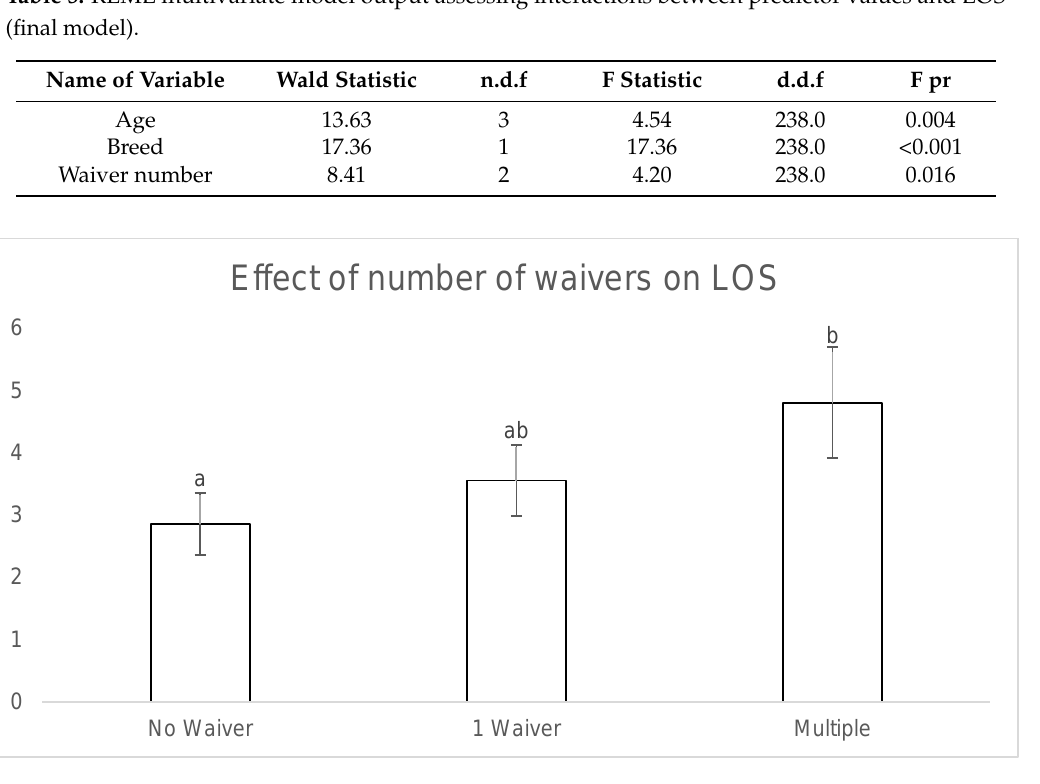
Figure 2. Effect of waiver number on LOS.